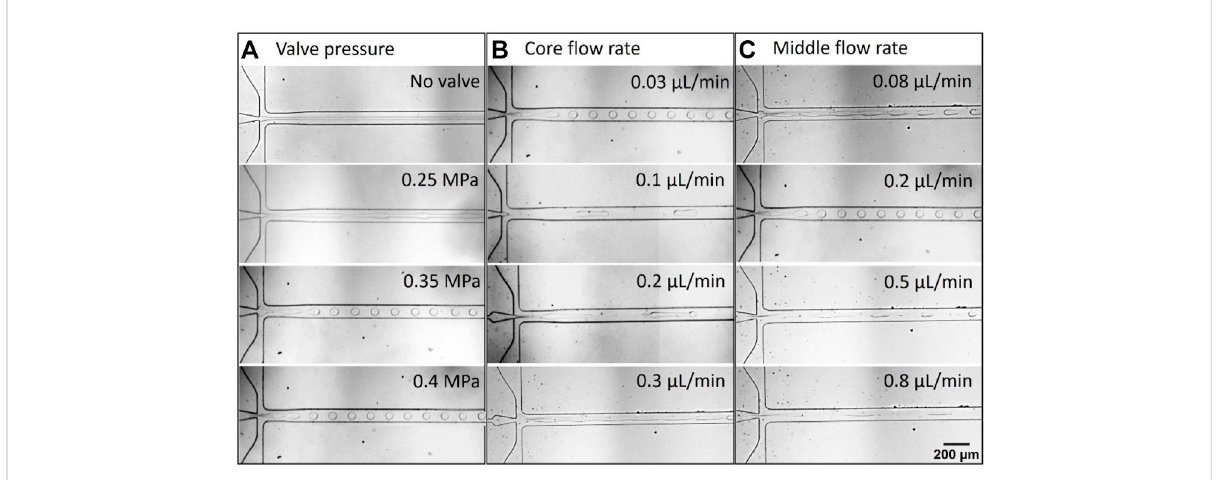
FIGURE 3 Dropletgenerationsnapshots;thein fl uenceofthedifferentoperatingparametersonthedroplets ’ generationsuchas; (A) pressuresofthevalve at the constant Q Core and Q Middle of 0.03 and 0.2 μ L/min, respectively, (B) Q Core at the constant Q Middle of 0.2 μ L/min and 0.35 MPa valve pressure, and (C) Q Middle at the constant Q Core of 0.03 μ L/min and 0.35 MPa valve